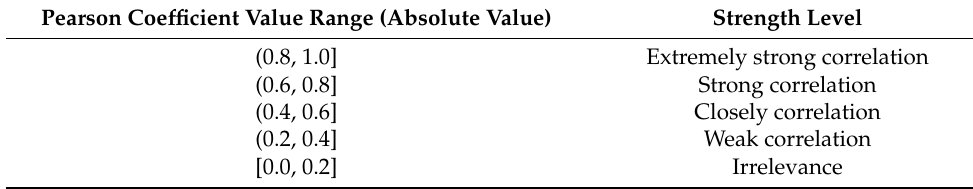
Table 2. Classification of correlation strength.